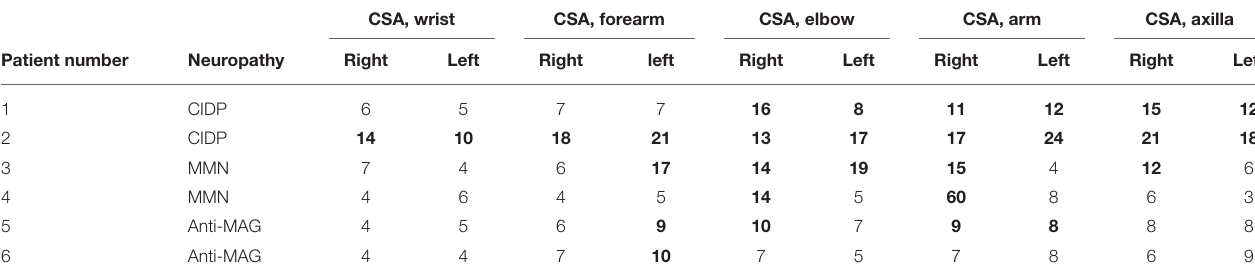
TABLE 3 | Ultrasound findings in the ulnar nerve at standard sites.